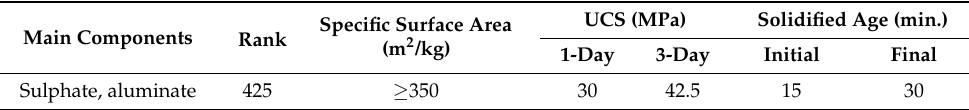
Figure 4. Air-drying of the soil. Table 2. Parameters for the No. 425 sulphate aluminate cement used for